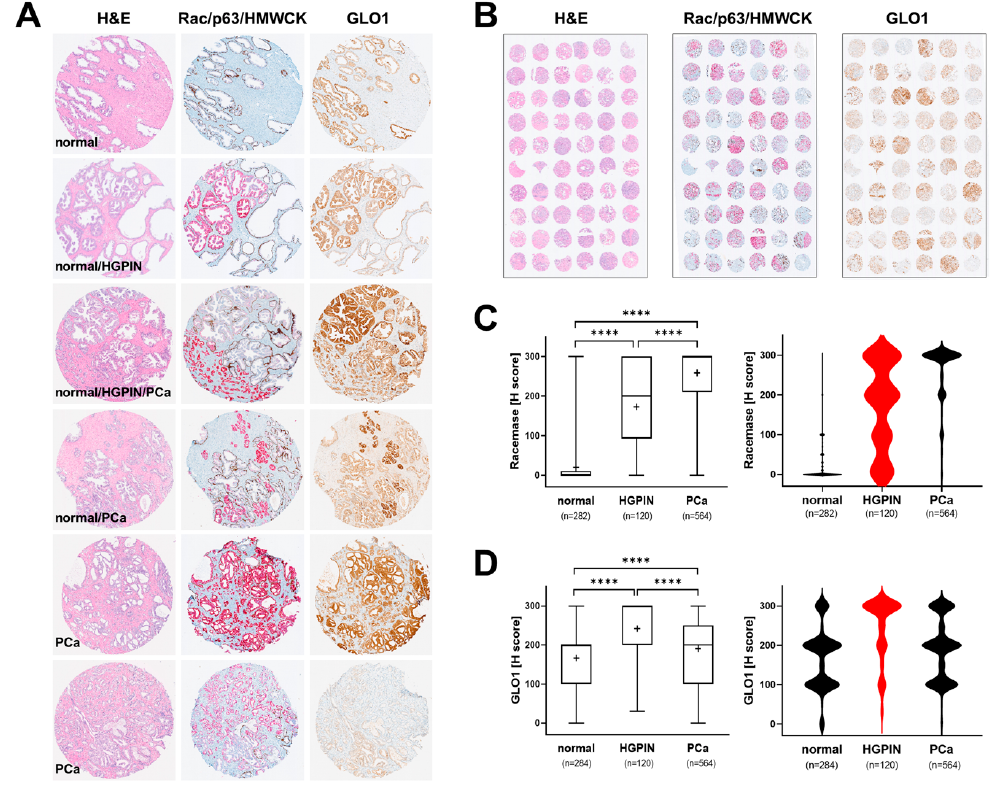
Figure 1. Comparative immunohistochemical analysis in prostate cancer tissue specimens: GLO1 versus standard (Rac/p63/HMWCK; ‘racemase’) staining. ( A ) Representative cores: H&E (left column), Rac/p63/HMWCK (middle column) and GLO1 (right column). ( B ) Representative TMAs stained as in panel A. ( C ) Racemase H-score comparison between adjacent normal, HGPIN, and PCa tissues (left: box and whisker plot; right: violin plot). ( D ) GLO1 H-score comparison between adjacent normal, HGPIN, and PCa tissues (left: box and whisker plot; right: violin plot). Statistical analysis of data was performed using the Kruskal–Wallis test (**** p < 0.0001); ‘+’ signifies the mean; HGPIN data depicted in red.